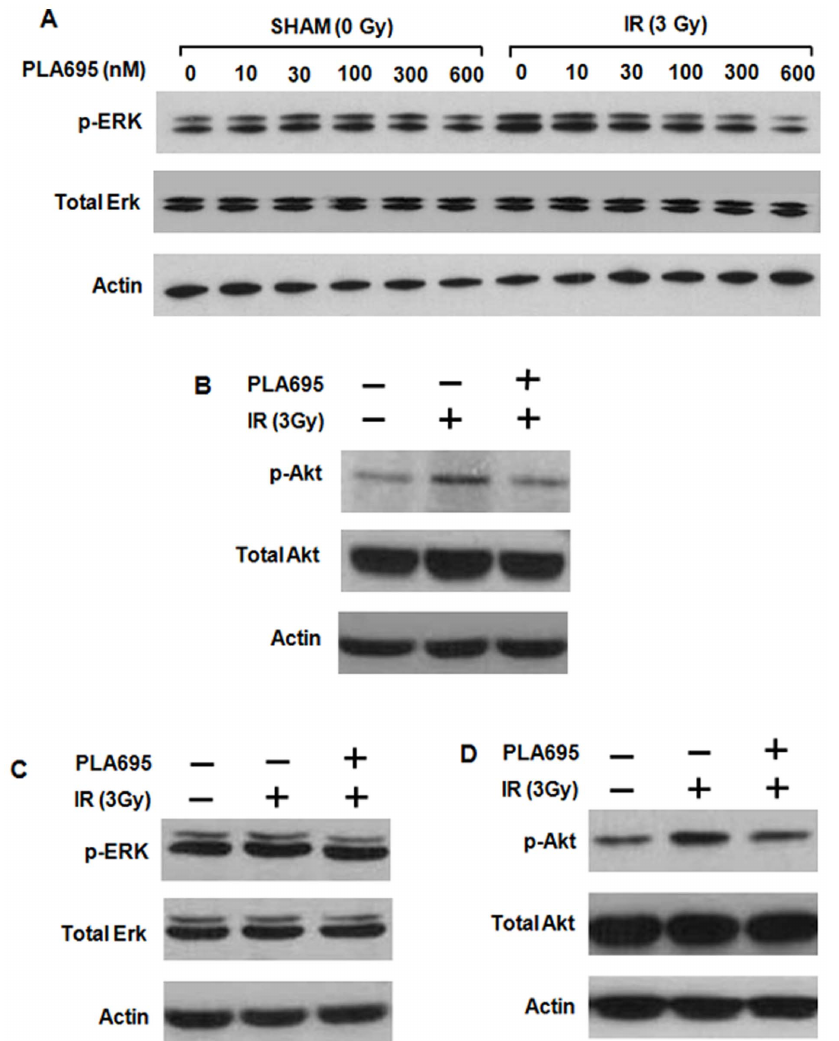
Figure 1. Effect of PLA-695 on pro-survival signaling after radiation. HUVEC cells (A) were treated with various concentrations of PLA-695 as indicated for 45 min before treatment with 3 Gy, cells were lysed at 5 min after IR. HUVEC (B) and 3B11 (C&D) cells were treated with 300 nM PLA-695 for 45 min before treatment with 3 Gy. Cells were lysed at 5 min after IR. Shown are immunoblot analyses using specific antibodies to phospho- Akt Ser473 , total Akt, phospho-ERK1/2, total ERK1/2, and